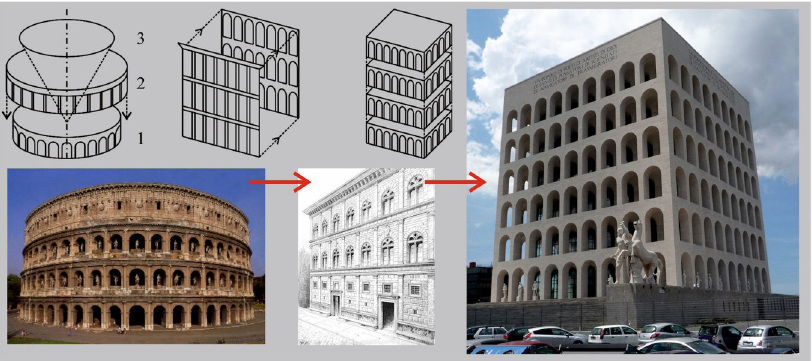
Figure 5. The method of historical association. Comparison of the Colosseum, Palazzo